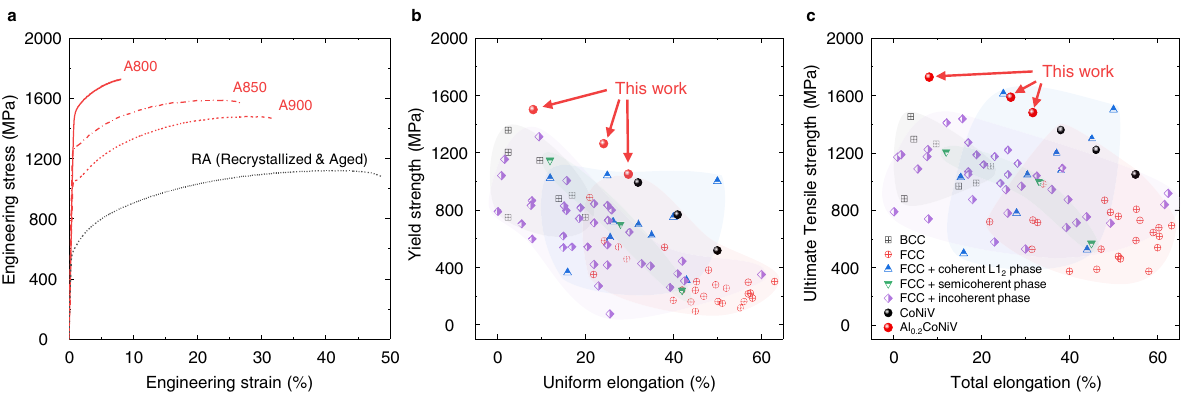
Fig. 4 Room-temperature mechanical properties of our alloys. a Engineering tensile stress – strain curves for the annealed Al 0.2 CoNiV alloys. b Overview of yield strength versus uniform elongation, and c Ultimate tensile strength versus total elongation values for the current Al 0.2 CoNiV alloy, compared to single or multiphase high-/medium-entropy alloys. The mechanical properties are summarized in Supplementary Table